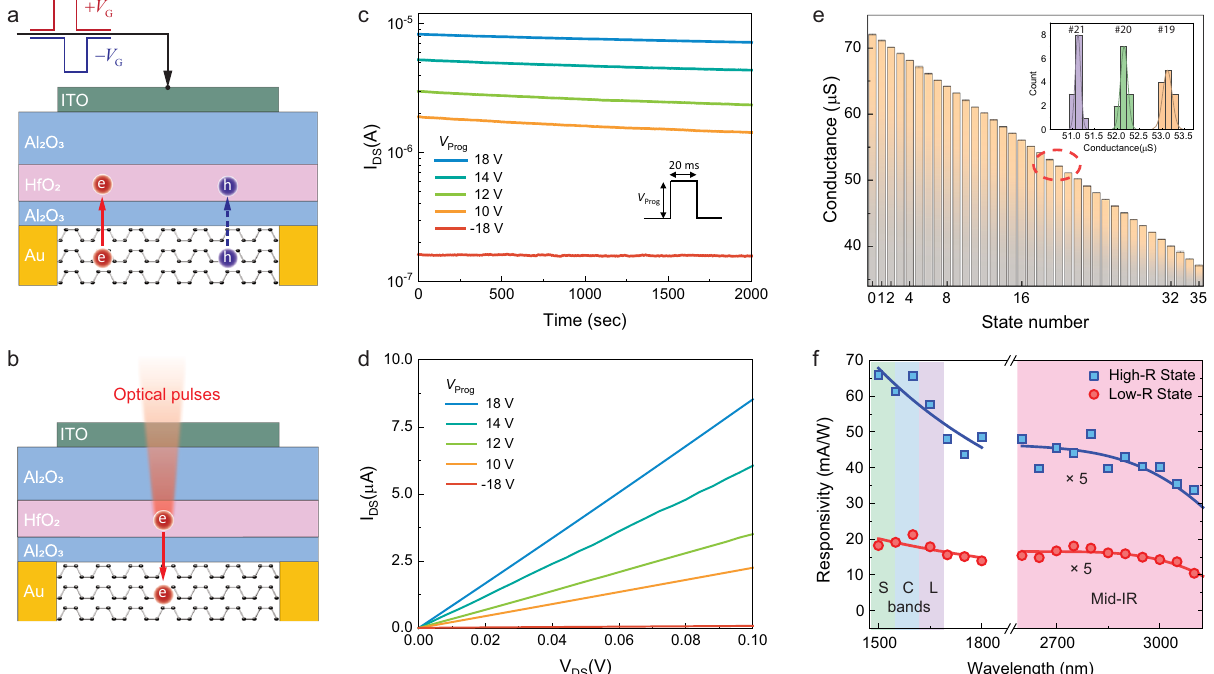
Fig. 2 Mixed-mode programming and operation of the bP-PPT device. Schematic illustrations of the working principle of programming the bP-PPT using a electrical gate voltage pulses and b optical pulses. The red and blue circles represent the electrons and holes in the bP channel or HfO 2 trap sites, respectively. V G is the applied top gate voltage. c The bP-PPT can be electrically programmed to 5 states of well-resolved conductance levels using pulses of different voltage amplitudes ( V prog ) with the fi xed pulse duration of 20 ms. Note that a negative repressive pulse ( − 18 V) resets the device to the lowest conductance. Inset: Illustration of the pulse shape of 20 ms in duration and V prog in amplitude. d The I – V characteristics of the device at each programmed state, showing the linear conductance ( g bP ). e The bP-PPT can be optically programmed using visible pulses to 36 levels in conductance. The inset shows the histogram of the well-separated conductance when the device is programmed repeatedly to three adjacent states indicated with the red dashed ellipse in the histogram. f The bP-PPT ’ s photoresponsivity over the near-IR (including the telecom S, C, and L-bands) and the mid-IR ranges. The discontinued spectral region is due to the gap of the laser tunability. The bP-PPT ’ s photoresponsivity can be programmed to two states when its conductance is set to high (state #0 in e ) or low (state #35 in e ). The solid lines are guides to the